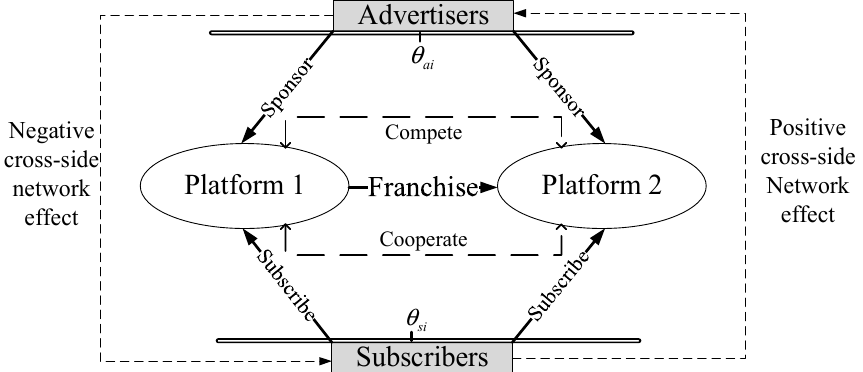
Figure 1. Platform’s co-opetitive strategy in a two-sided market. The decision sequence of the platforms is shown in Figure 2.